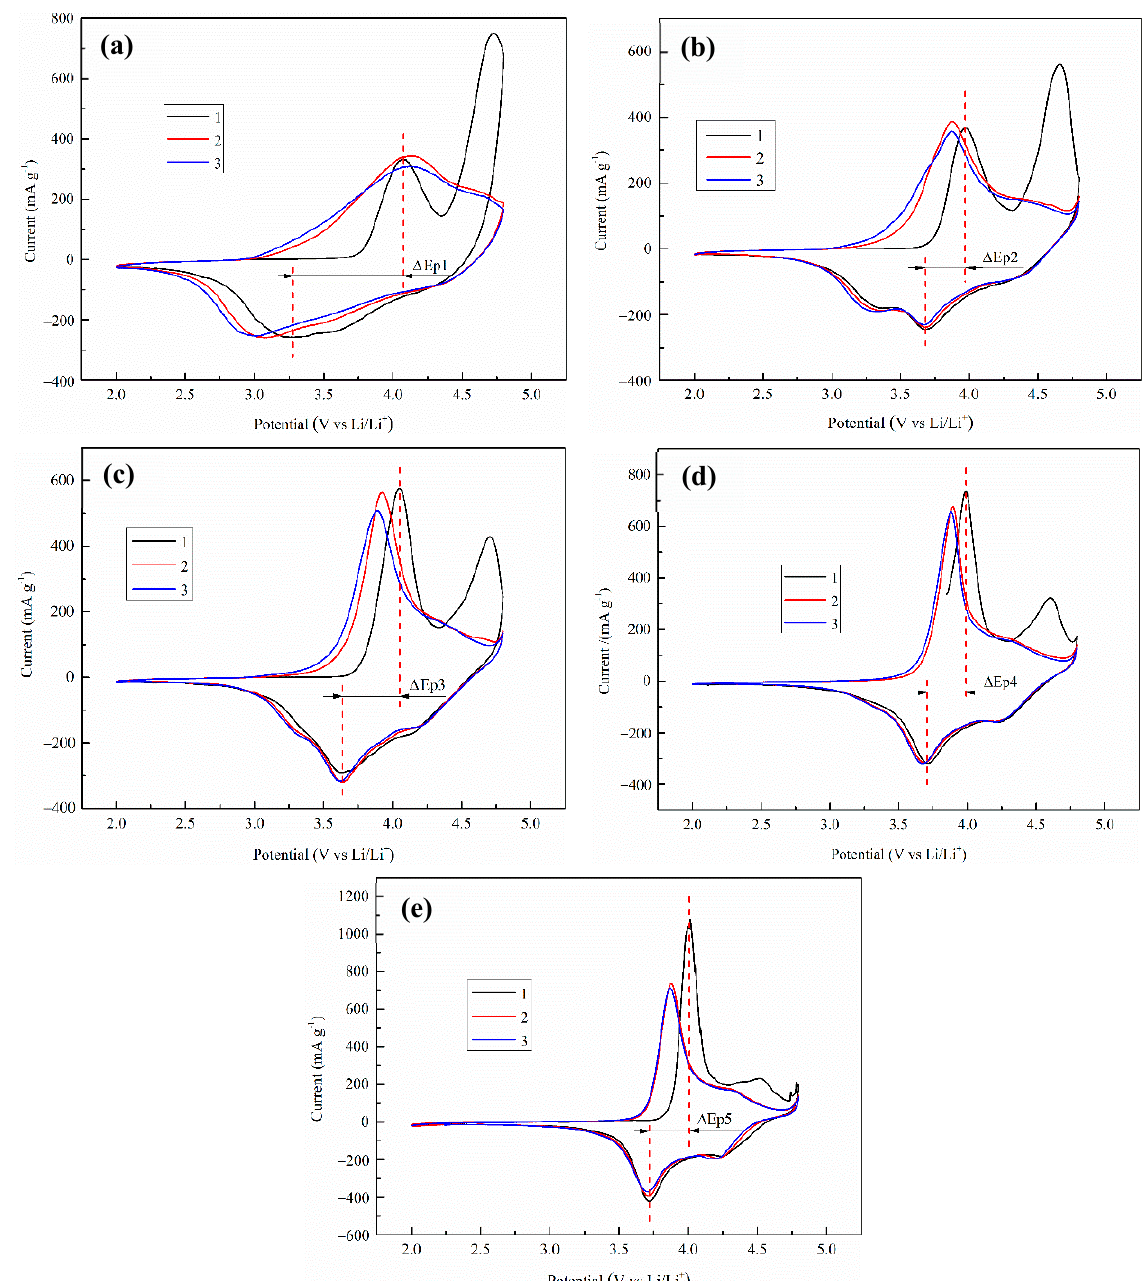
Figure 11. CV curves of ( a ) LMNCO, ( b ) nLMNCO-1.0, ( c ) nLMNCO-2.0, ( d ) nLMNCO-3.0 and ( e ) nLMNCO-4.0 cathode materials.